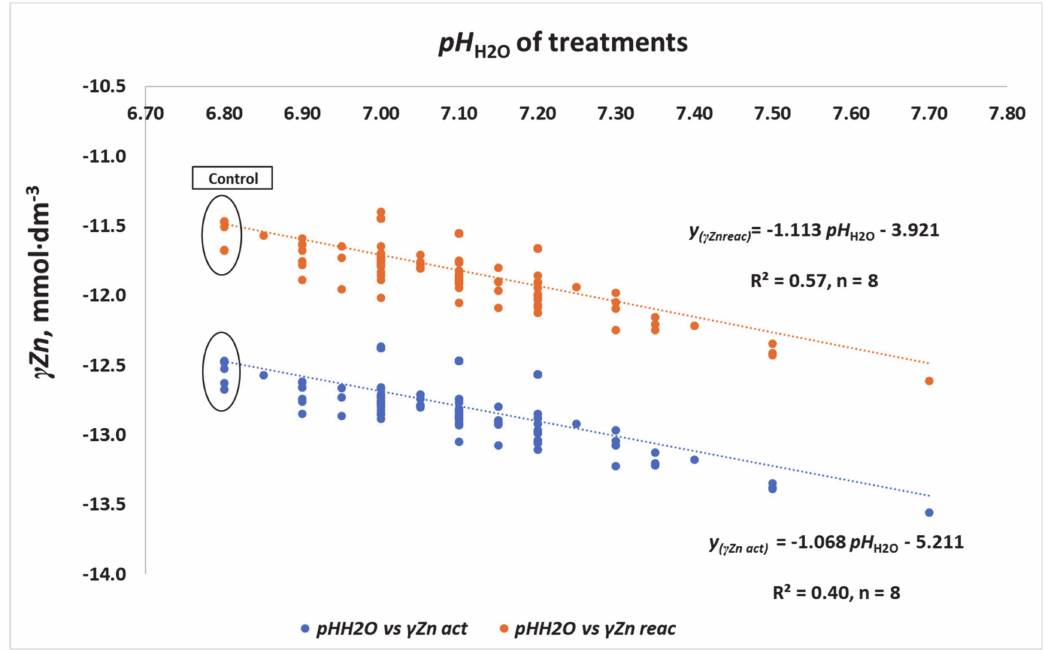
Figure 6. Relationships established for the pairs Zn activities of the active ( Zn act ) and reactive ( Zn reac ) fractions versus pH of the sorbents treated